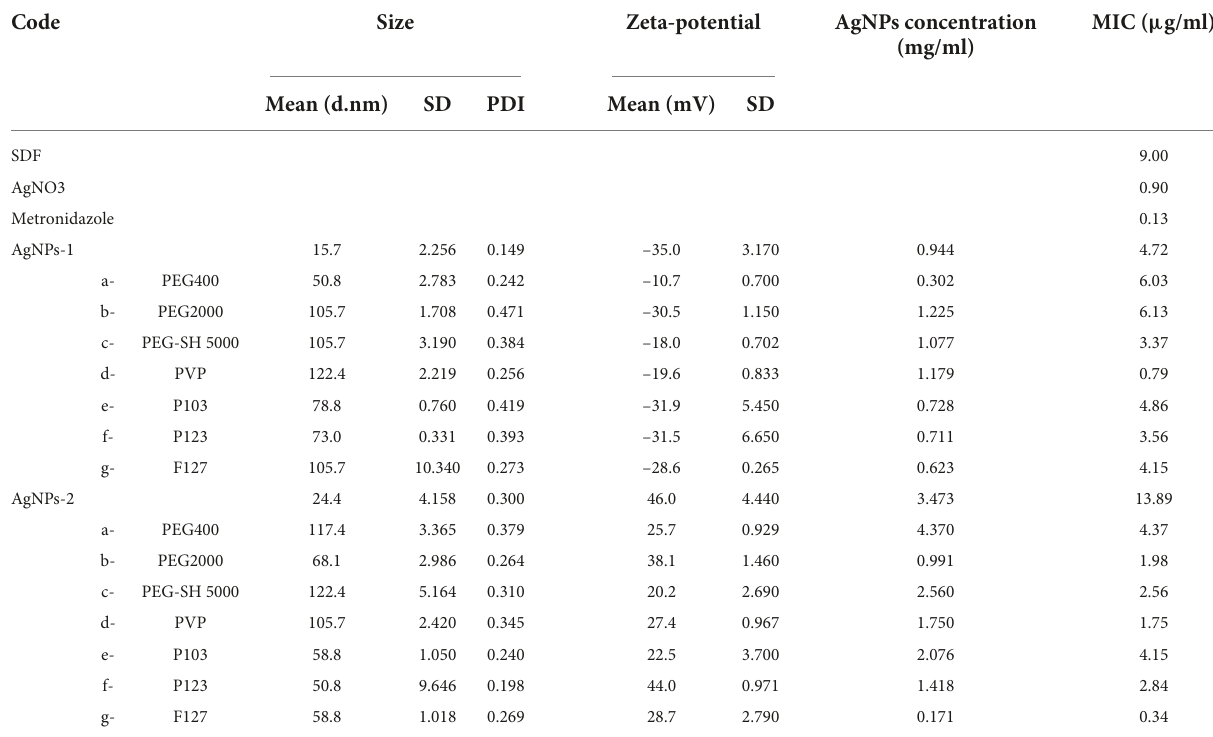
TABLE 1 Summary of the nano size, zeta-potential (DLS), silver concentration (ICP-OES), and MIC values for AgNPs-1/2 and